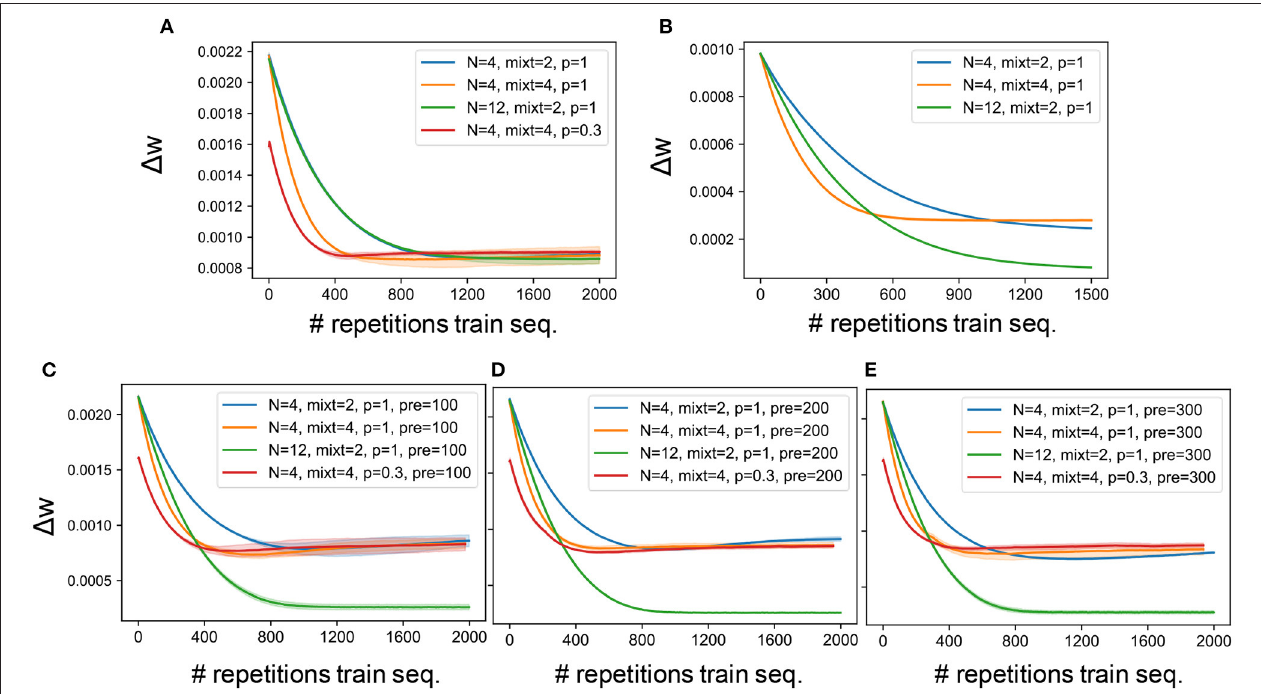
FIGURE 3 | Learning curves. (A) Average synaptic weight change for the experiments carried out on the synthetized sounds, the network being initialized with random values. (B) Average synaptic weight change for the experiments carried out on the natural sounds, the network being initialized with random values. (C) Average synaptic weight change for the experiments carried out on the synthetized sounds, the network being pretrained on the targets set presented for 100 epochs. (D) Average synaptic weight change for the experiments carried out on the synthetized sounds, the network being pretrained on the targets set presented for 200 epochs. (E) Average synaptic weight change for the experiments carried out on the synthetized sounds, the network being pretrained on the targets set presented for 300 epochs. The solid line and the shaded area represent the mean and standard deviation over 3 independent runs, respectively. Without pretraining, when the number of output neurons is varied no significant change is found, while with pretraining when a larger number of neurons is used, the weight change curve saturates at a lower value, as shown by the blue ( N = 4) and green ( N = 12) curves. Furthermore, the figures show that both when a larger number of training mixtures is presented (yellow curves) and when only 30% of the connections are kept (red curves) the slope of the learning curve is steeper. The weight change is computed by storing the weights values every 2,000 time steps (i.e., “fire” or “non-fire” events) and computing the standard deviation over the last 100 recorded values. The standard deviation is then averaged across all connections from input to output neurons. Therefore, each point on the curve reports the average weight change over the past 2000 × 100 time steps. Note that each sound/mixture is presented for 400 time steps. Finally, the x-axis shows the number of repetitions of the training mixture sequence (2,000 for synthetic sounds and 1,500 for naturalistic